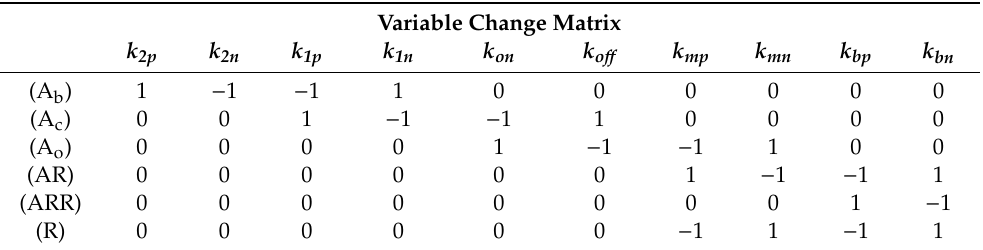
Table 3. Variable change